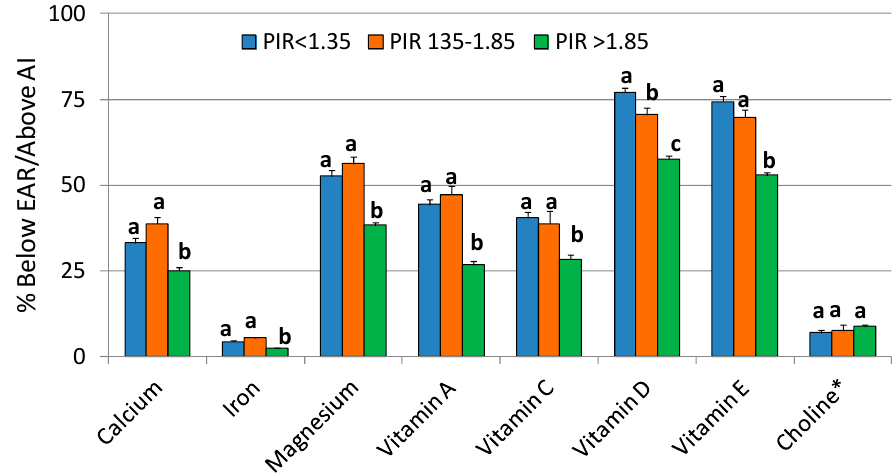
Figure 1. Comparison of percent adult (19+ years old) population below Estimated Average Requirement (EAR) or above Adequate Intake (AI) of DGA-identified “underconsumed nutrients” from foods + dietary supplements among different socioeconomic subgroups. NHANES 2009–2012 gender combined data. Bars with different letters for one nutrient are significantly different at p < 0.01. * AI Nutrient.